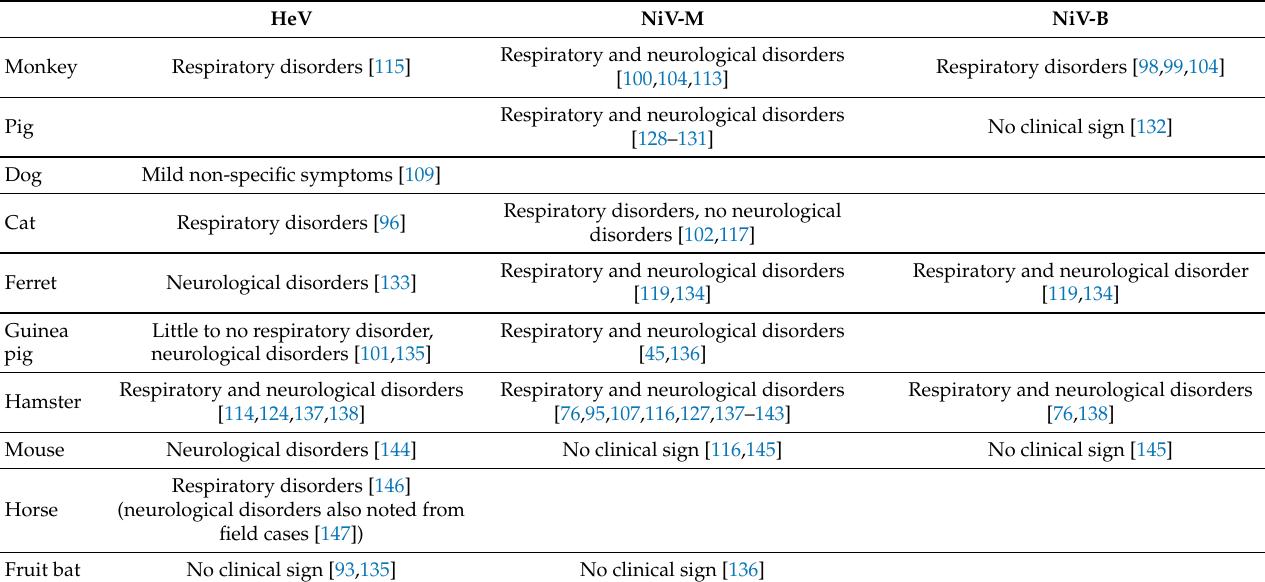
Table 3. Clinical signs resulting from experimental henipavirus infections. Blank cells indicate that no data are